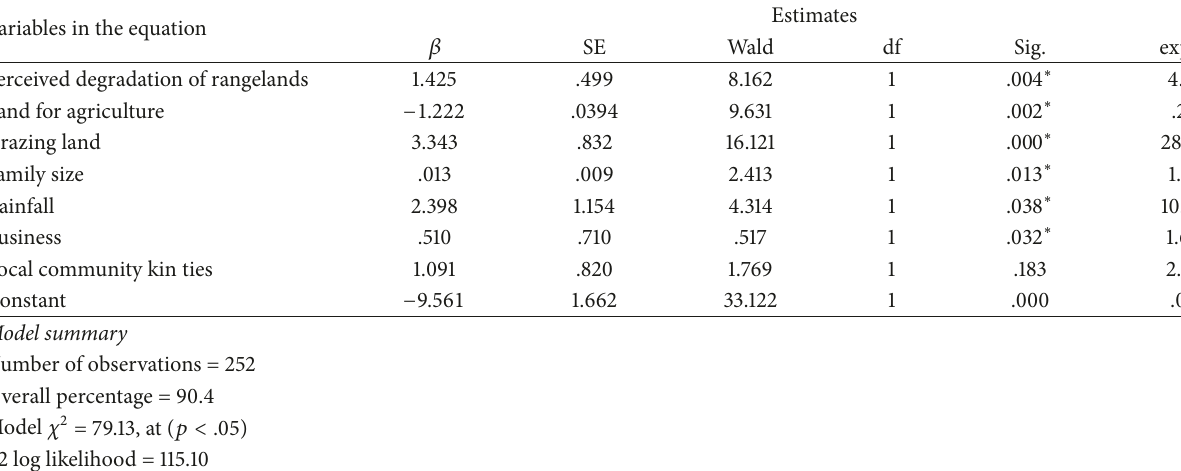
Table 5: Logistic regression results predicting factors influencing migration of agropastoralists into frontier landscapes. Variables in the equation